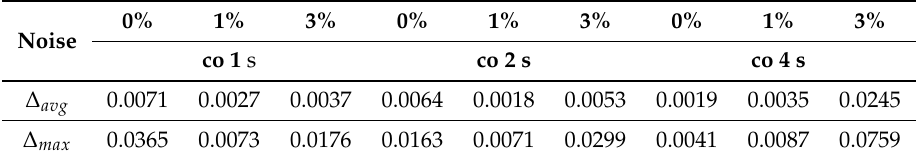
Table 4. The errors of the function u reconstruction for the measurement points in the case of two